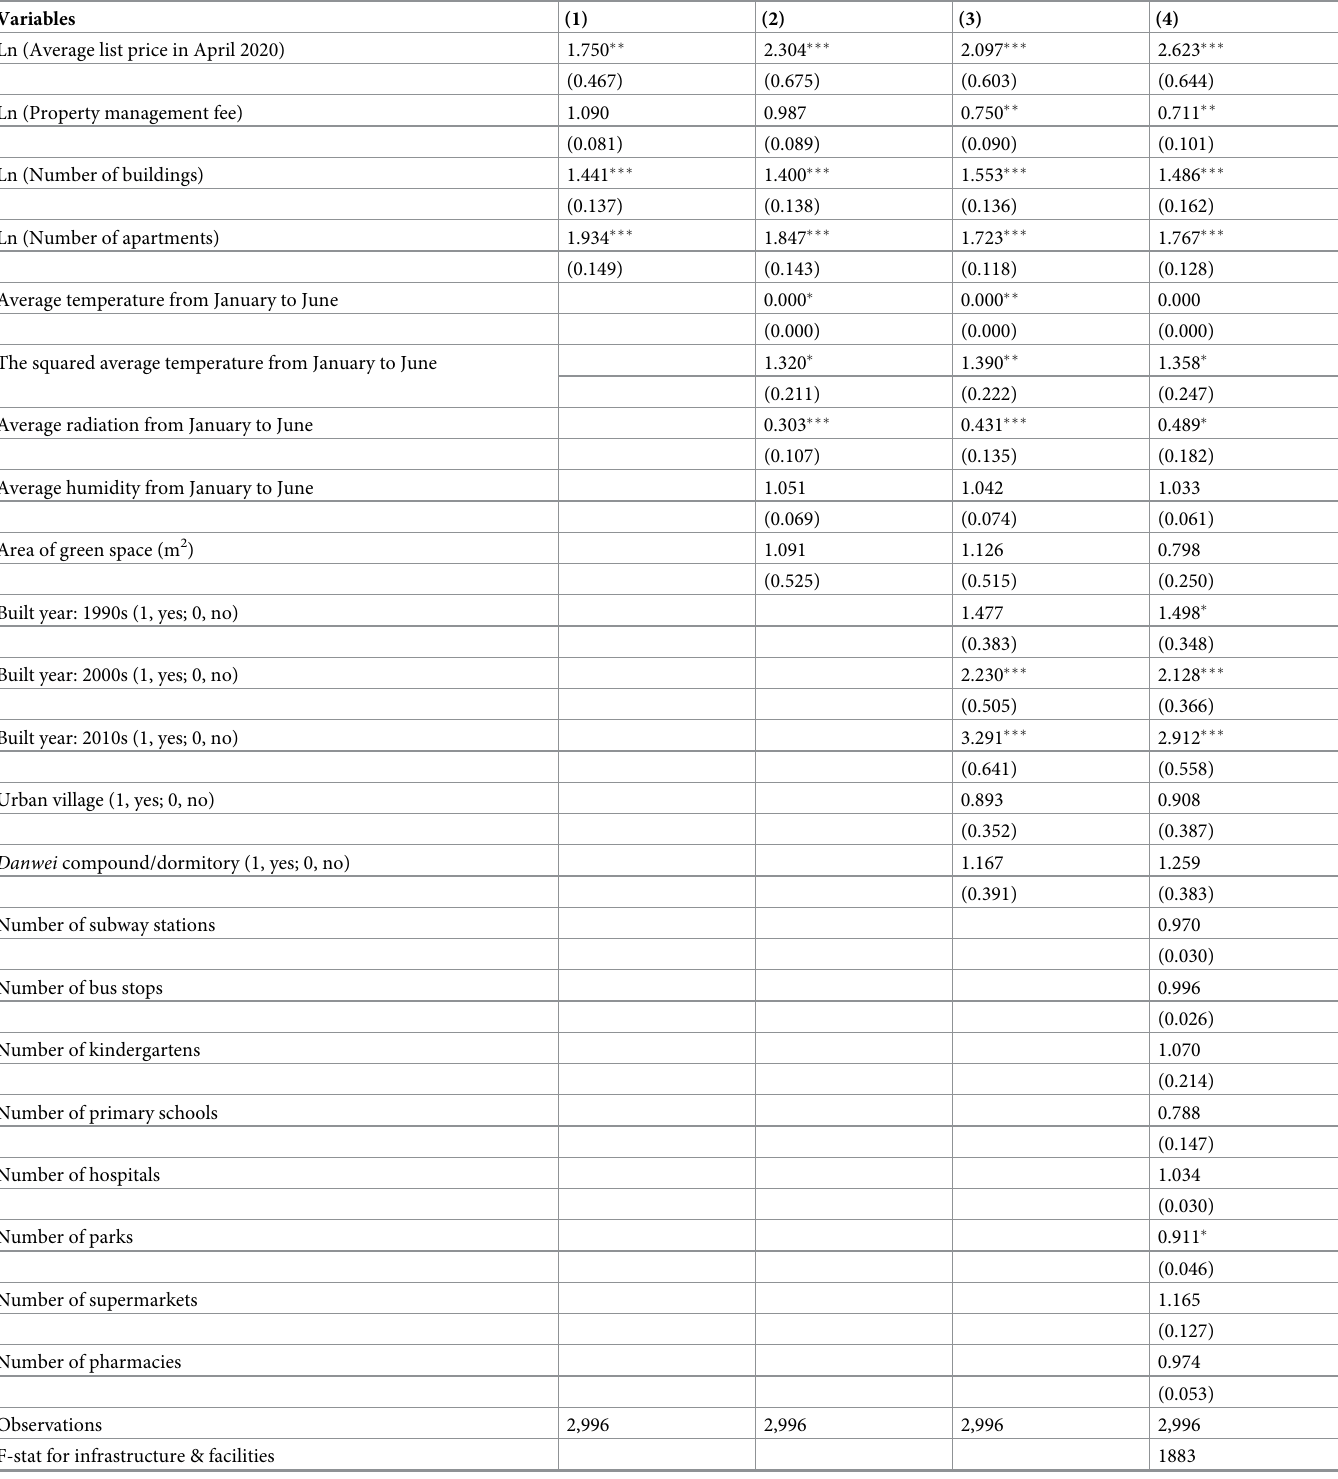
Table 3. The logit model results for COVID-19 infection odds ratio (OR).